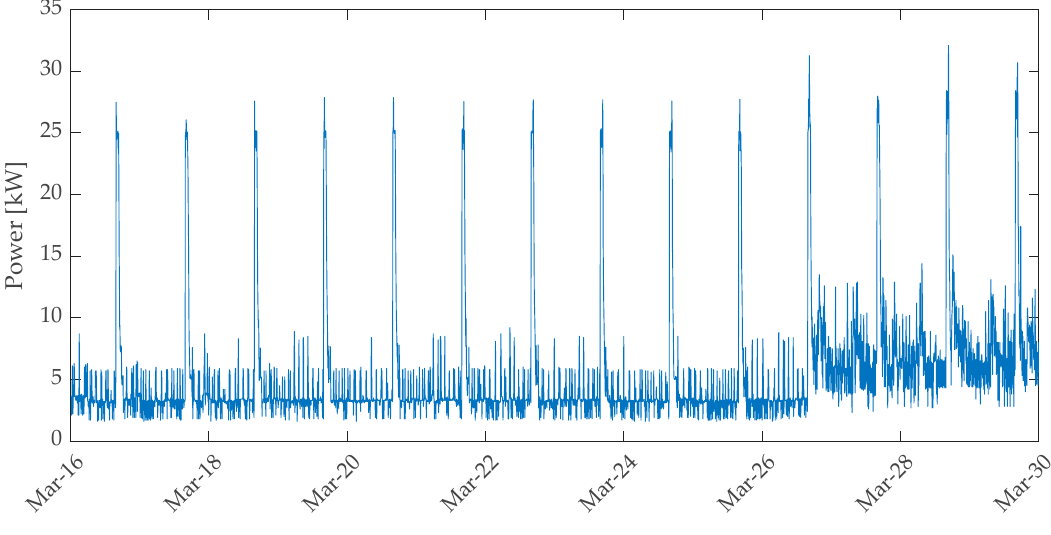
Figure 5. Demand from the load.